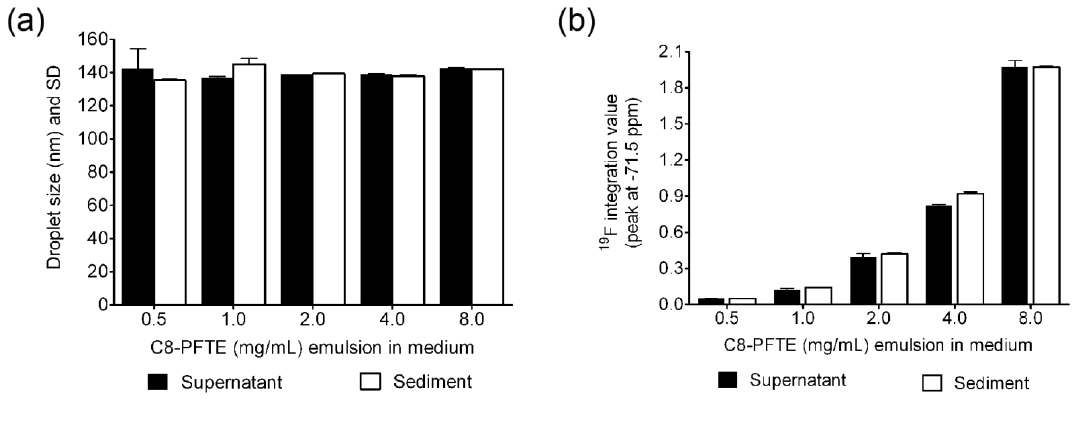
Figure 8. ( a ) Graph showing droplet diameter before and after centrifugation of nanoemulsion M2 in cell-exposed nanoemulsion dispersed medium. ( b ) Integrated values of C8-PFTE 19 F resonance peak in the supernatant and sediment of cell-exposed nanoemulsion dispersed medium. Error bars are standard deviation from mean of duplicate